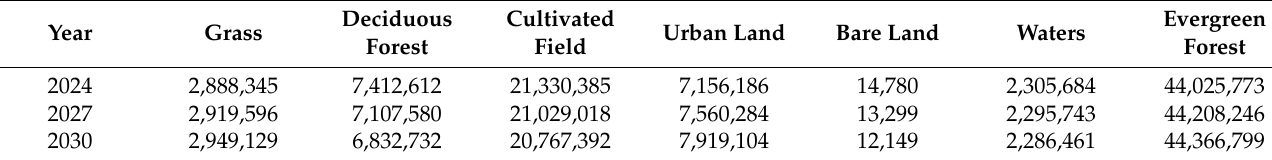
Table 4. Simulation of land use types in 2024, 2027, and 2030 (km 2